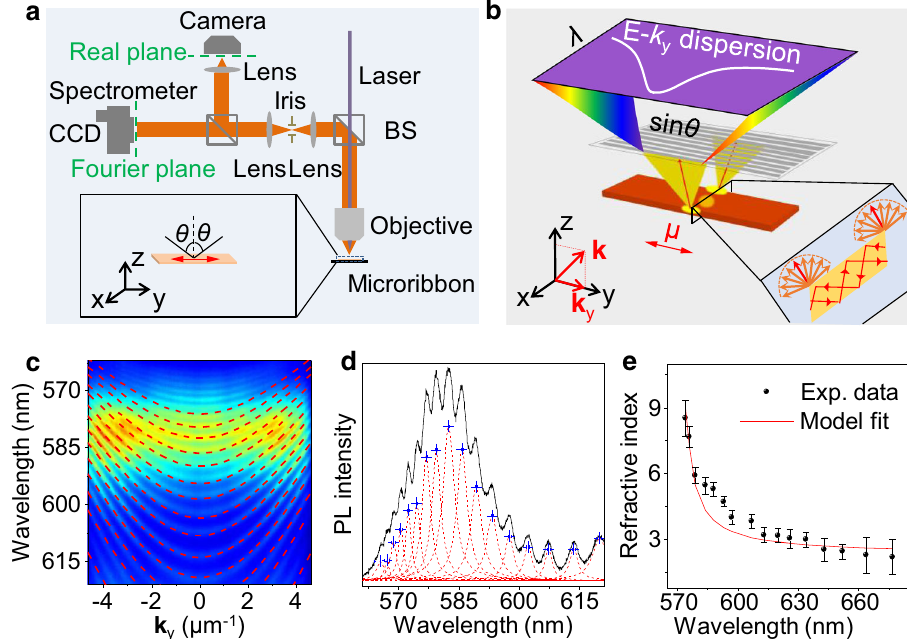
Fig. 2 Strong coupling in the PDI-O microribbon cavity. a Schematic of the experimental setup for AR μ -PL measurement. CCD: charge coupled device. BS: beam splitter. b Schematic of a PDI-O microribbon along with coordinate axes. The waveguide F – P cavity direction is parallel to the x -axis direction. k y is the projection of wave vector on to y -axis, which depends upon the emission angle in y – z plane ( θ ). c AR μ -PL spectrum of the PDI-O microribbon. Dashed curves are fi tted dispersions of polariton modes obtained from the coupled oscillator model. The microribbon was excited by a 405 nm CW laser. d PL spectrum of the PDI-O microribbon. The dashed lines are fi tted Lorentzian line shapes to measure the mode spacing Δ λ for calculation of refractive index. Error bars indicate the 95% con fi dence intervals of the fi tted peak positions. e Refractive index derived from the coupled oscillator model (red line) and calculated from experimental data (black dot). Error bars indicate the 95% con fi dence intervals propagated from the 95% con fi dence intervals for the fi tting of the PL spectrum in d